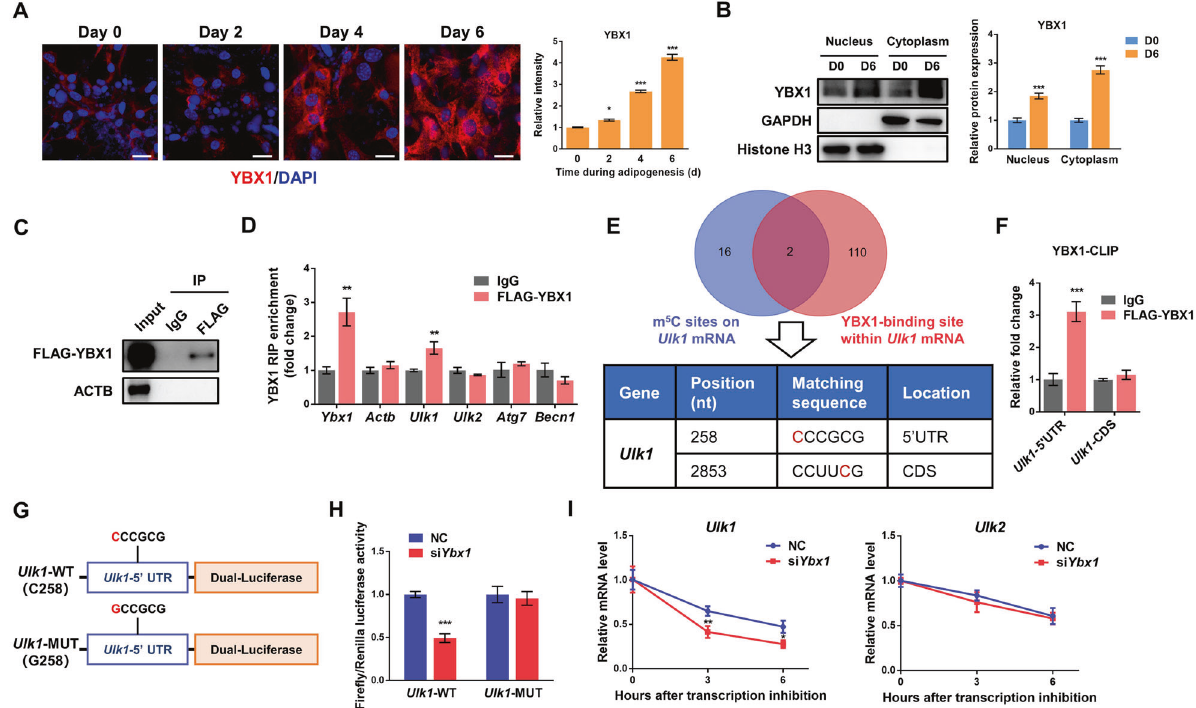
Fig. 5 YBX1 as an m 5 C reader speci fi cally binding and mediating mRNA stability of Ulk1 . A Immuno fl uorescence detection of YBX1 during adipogenesis. Scale bar: 20 μ m. B Western blot analysis of nuclear and cytoplasmic distribution of YBX1 in 3T3-L1 cells on day 0 or 6 of adipogenesis. Histone H3 and GAPDH serve as nuclear and cytoplasmic markers, respectively. C Western blot to con fi rm the immunoprecipitation of FLAG protein. D RNA immunoprecipitation-qPCR (RIP-qPCR) analysis of the interaction of Ulk1 or Ulk2 transcript with FLAG in cells overexpressing FLAG-tagged YBX1. Ybx1 was used as a positive control, while Actb was used as a negative control. E Venn diagrams show 2 m 5 C sites are also predicted YBX1-binding sites within Ulk1 transcripts by the RBPDB database. Red C in match sequence represents m 5 C. F RIP-qPCR analysis of the interaction of 5 ’ UTR or CDS of Ulk1 transcript with FLAG in cells overexpressing FLAG-tagged YBX1. G Schematic diagram of dual-luciferase reporter constructs containing a Ulk1 -m 5 C wild type site ( Ulk1 -WT) or mutant site ( Ulk1 -MUT). H Relative luciferase activity of Ulk1- WT or - MUT luciferase reporter in NC and YBX1 knockdown cells. Fire fl y luciferase activity was measured and normalized to renilla luciferase activity. I mRNA lifetimes of Ulk1 and Ulk2 in NC and YBX1 knockdown cells. The data were presented as the mean ± SD of triplicate tests. * P < 0.05, ** P < 0.01, *** P < 0.001 compared to control